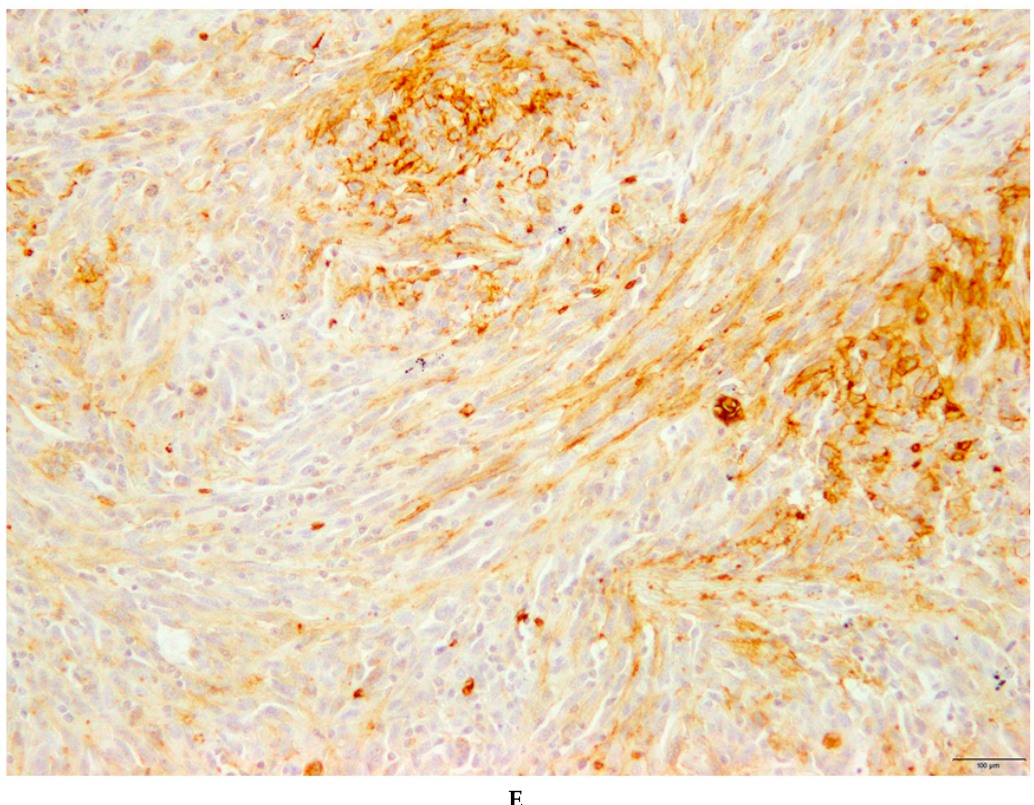
Figure 1. An 88-year-old male with PPC including a component of squamous cell carcinoma ( A ) GLUT1 was stained on the membrane of tumor cells, showing a score of 4. A 78-year-old female with PPC including components of squamous cell carcinoma and spindle cells: GLUT1 was stained throughout the squamous cell carcinomas ( B ) and partial lesions of spindle cells ( C ). A 77-year-old male with PPC including components of adenosquamous cell carcinoma and giant cells: GLUT1 was stained throughout the epithelial cells ( D ) and sarcomatous cells ( E ).